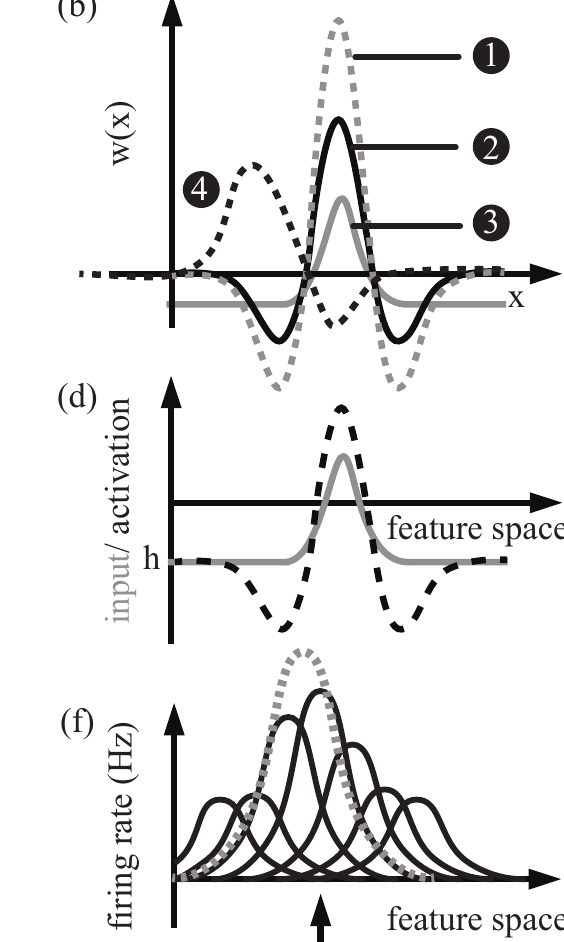
Figure 1. Dynamic neural field components and distribution of population activation. (a) The sigmoid function.